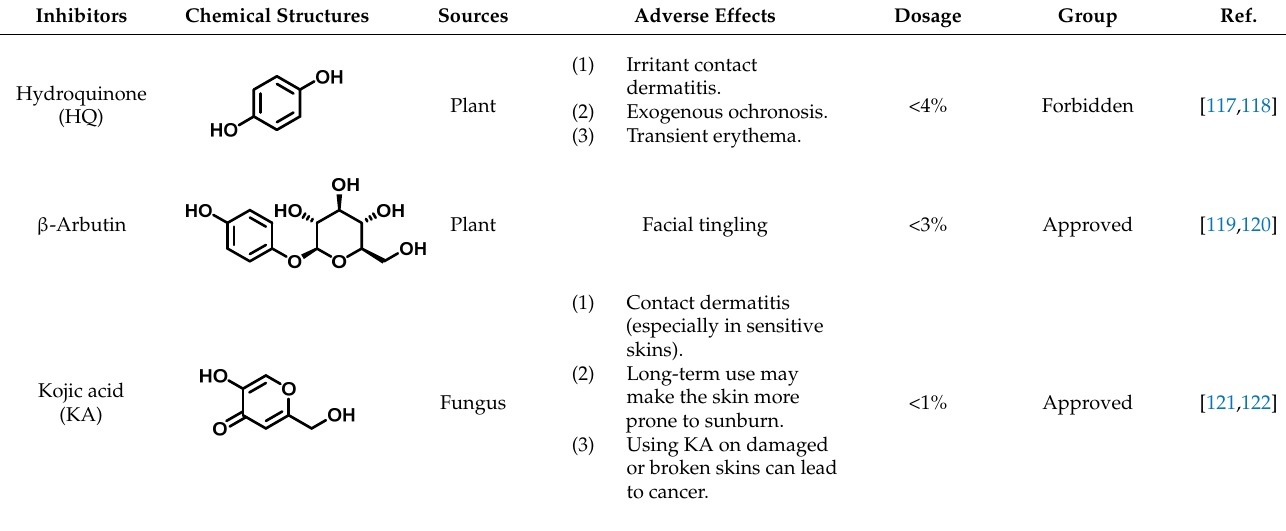
Table 4. The commonly used positive inhibitors and their adverse effects.